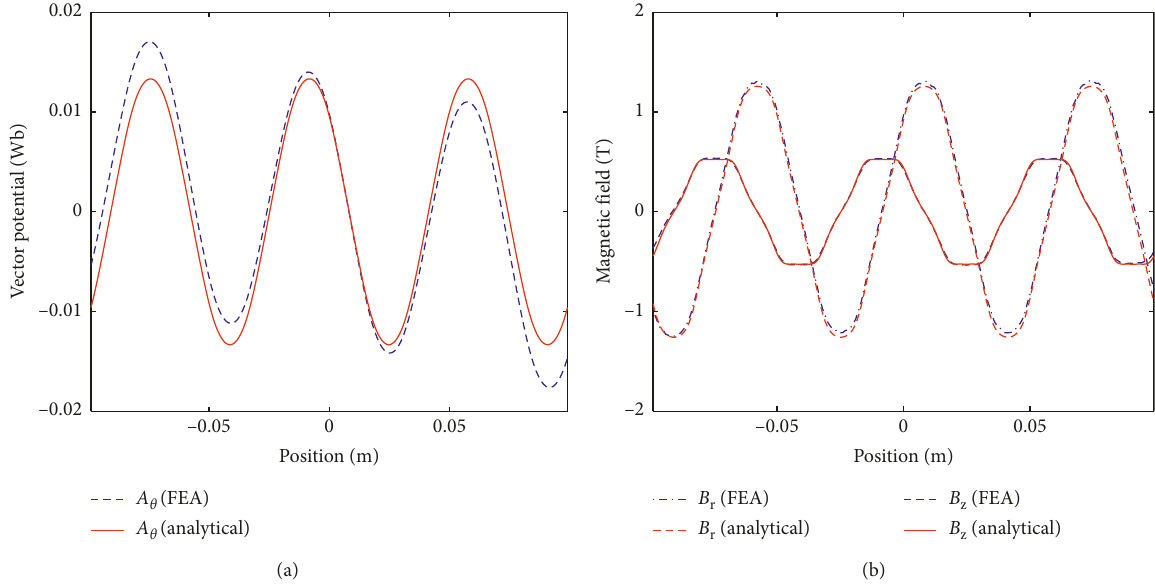
Figure 2: The FEA and analysis results of winding magnetic field. (a) Axial distribution of magnetic vector potential. (b) Axial distribution of magnetic